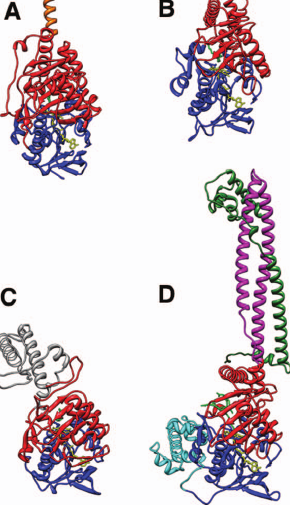
Figure 1 Ribbon representations of human MAO B (A), maize PAO (B), bacterial LAAO (C), and human LSD1 (D). Images were generated using the program Chimera (115) and the following Protein Data Bank (PDB) files: 1OJA, 1H83, 2JB2, and 2UXN. The FAD-binding domains are colored blue and substrate- binding domains are red; substrate analogs or inhibitors are colored green and the flavin cofactors are yellow. The C-terminal membrane-binding a -helix of MAO B is colored orange; the helical domain of LAAO is gray. The tower domain of LSD1 (magenta) is shown interacting with a portion of CoREST, colored dark green, and the SANT domain of LSD1 is